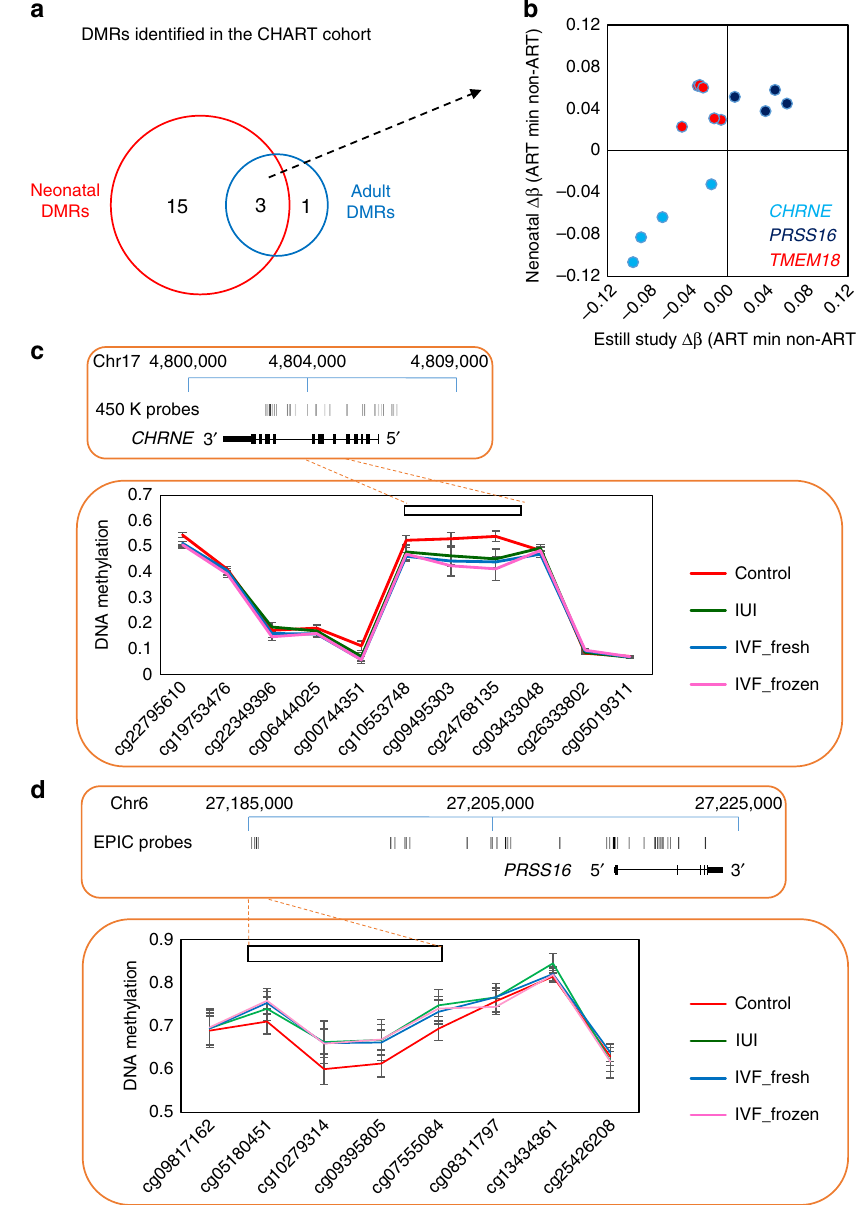
Fig. 4 Validation of ART-associated differentially methylated regions in an unrelated cohort. a . Summary of three ART-DMRs that are detected in both neonatal and adult blood. b Scatterplot of individual probes within the three DMRs at CHRNE , PRSS16 and TMEM18 genes, with mean Δβ for neonatal blood in our cohort (CHART) shown on y axis and mean Δβ for neonatal blood in the 450K cohort shown on x axis. DMRs at CHRNE and PRSS16 correlate well between the two studies. c Map of the CHRNE gene in hg19, showing EPIC probe locations and mean DNA methylation level at the ART-DMR in the 450K study. d Map of the PRSS16 gene in hg19, showing EPIC probe locations and mean DNA methylation level at the ART-DMR in the 4 study. Error bars are 95% CI. n = 133 biologically independent birth